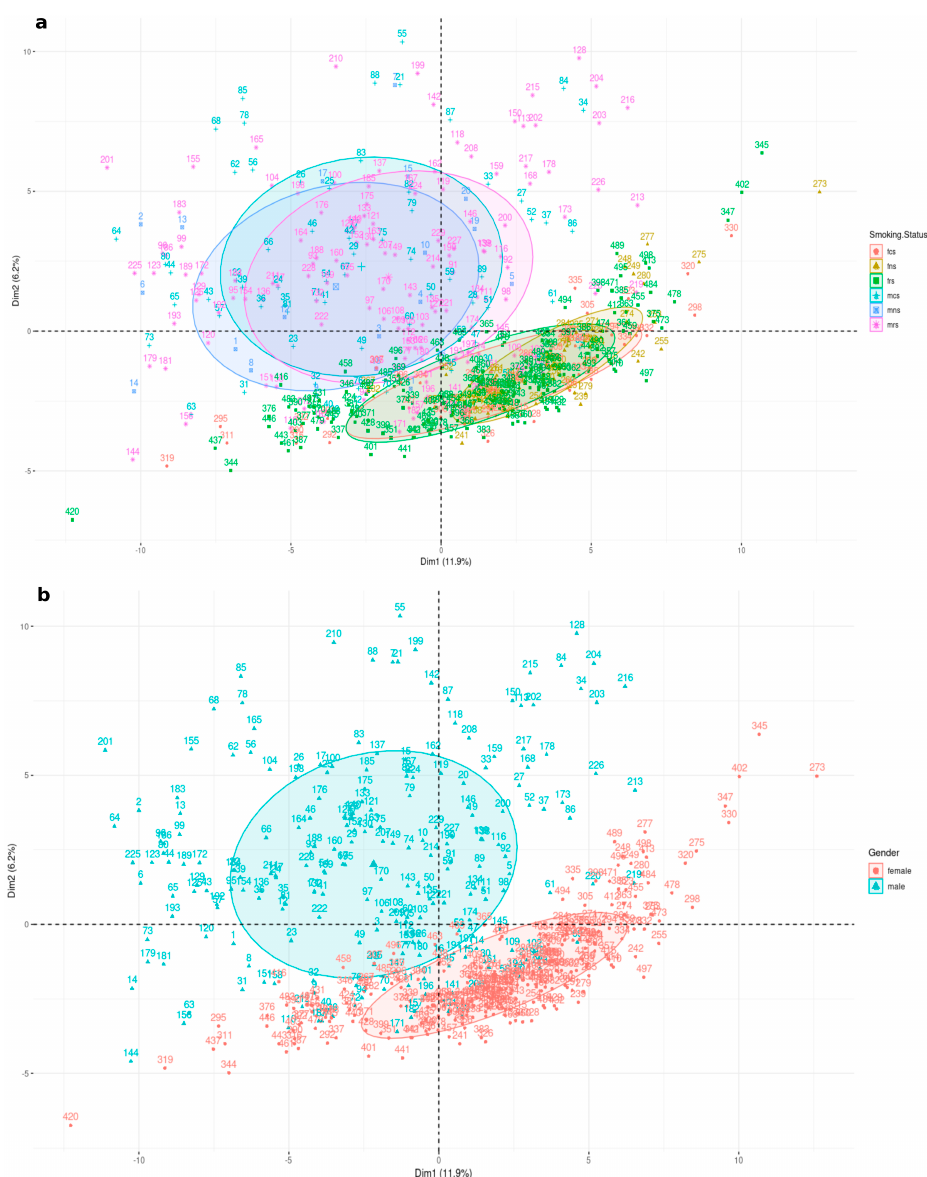
Figure 2. Principal component analysis performed on expression data for 161 genes for all 6 LUAD subgroups. Subgroups clusters are represented on the factorial plane by coloured ellipses reflecting their association with 11.9% and 6.2% of the total variability for the first two dimensions. Figure ( a ) represents all six groups: male never smokers (MNS), current smokers (MCS), female never smokers (FNS) and female current smokers (FCS), while figure ( b ) represents males and females collectively